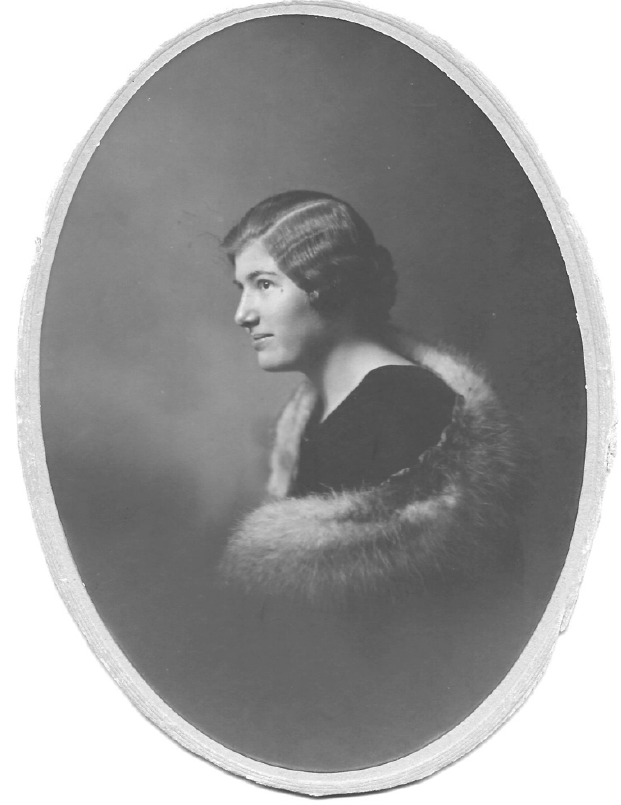
Figure 1. Maria Fenski, 1927.